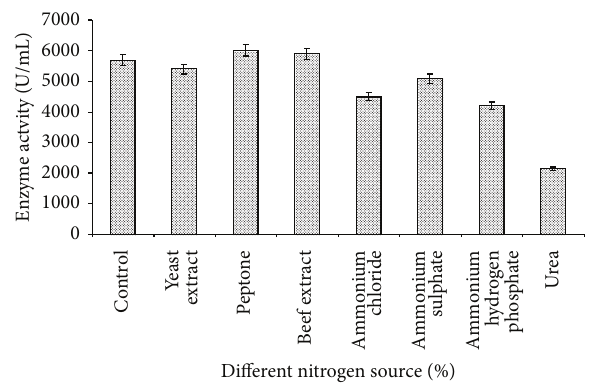
Figure 8: Effect of different nitrogen sources on amylase produc- tion. The control flask does not contain any nitrogen sources. Test flasks contained different nitrogen sources in the medium at a level of 0.5% (w/v). The flasks were inoculated with culture and incubated at 55 ∘ C for 24 h at pH 7.0 with 4.0% starch. Error bars presented are mean values of ± standard deviation of triplicates of three independent experiments.